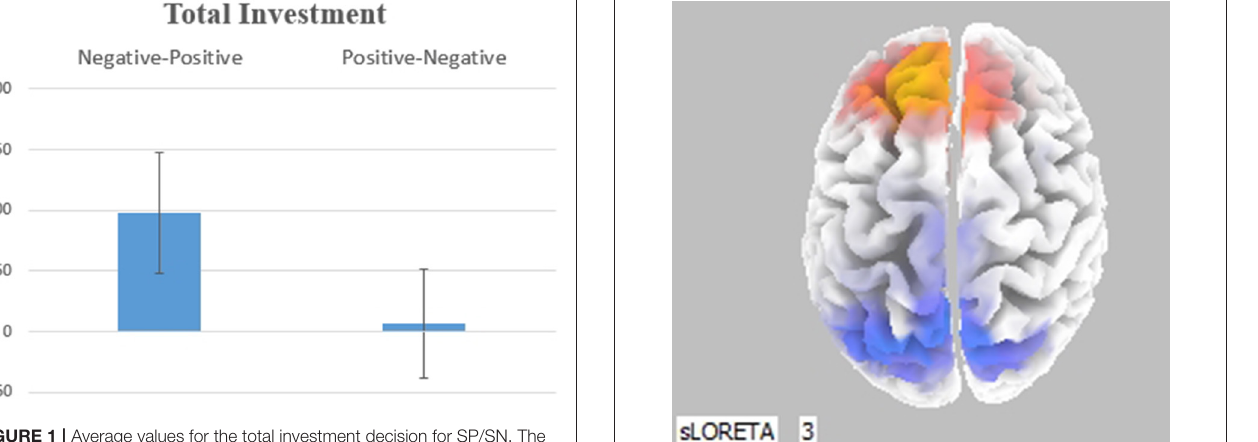
FIGURE 1 | Average values for the total investment decision for SP/SN. The difference was statistically significant at F (1,17) = 4.711, p = 0.044.